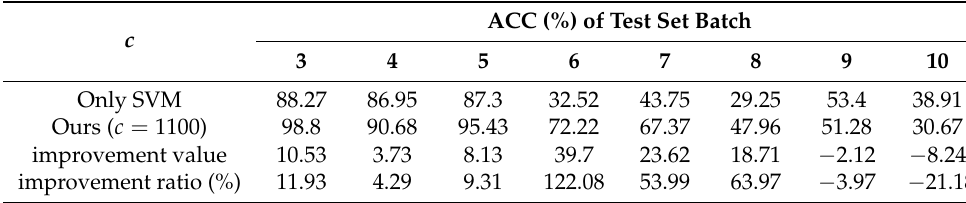
Table 8. Experimental comparison for